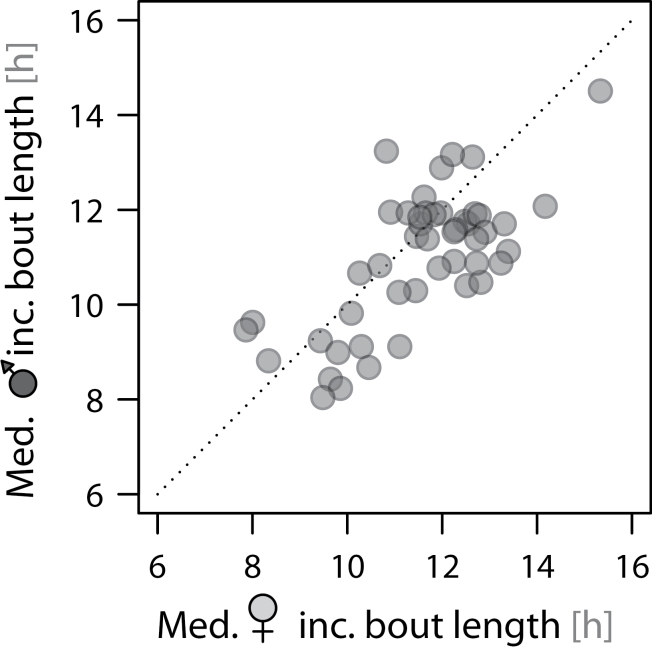
Between- and within-pair differences in the median length of incubation bouts. Each dot represents 1 nest. The correlation of the median bouts between sexes: Pearson correlation coefficient (95% CI): r = 0.71 (0.53–0.83), t
46 = 6.8, P < 0.0001.